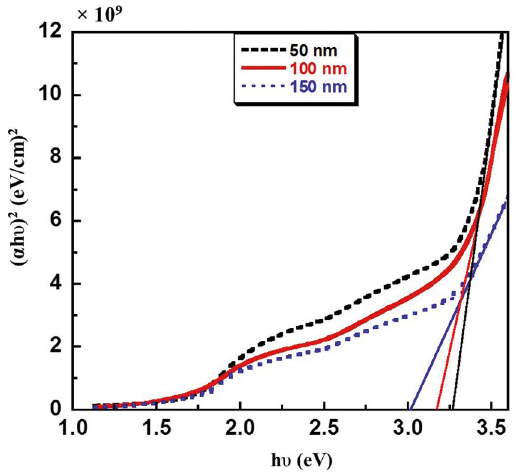
Figure 8: (αhυ) 2 versus photon energy ( hυ) plots for V: In with different thicknesses of (a) 50 nm, (b) 100 nm and (c) 150 nm. Table 2: Optical band gap of V: In thicknesses